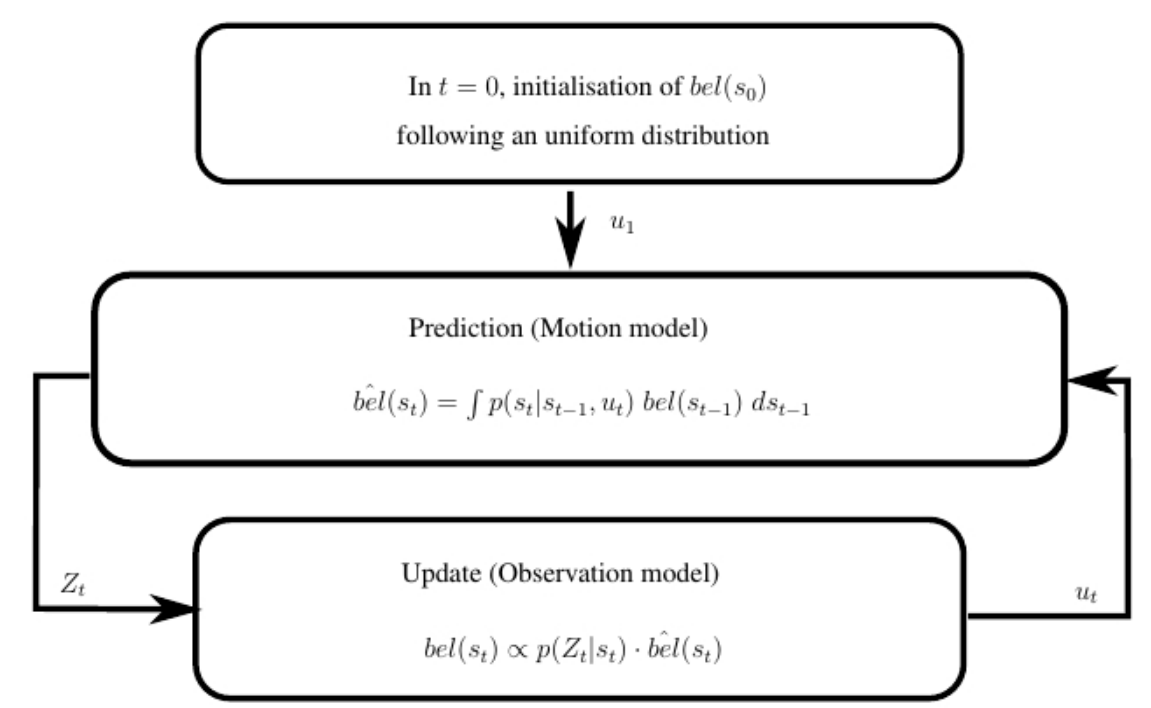
Figure 2. Block diagram of the recursive Bayes filter for mobile robot